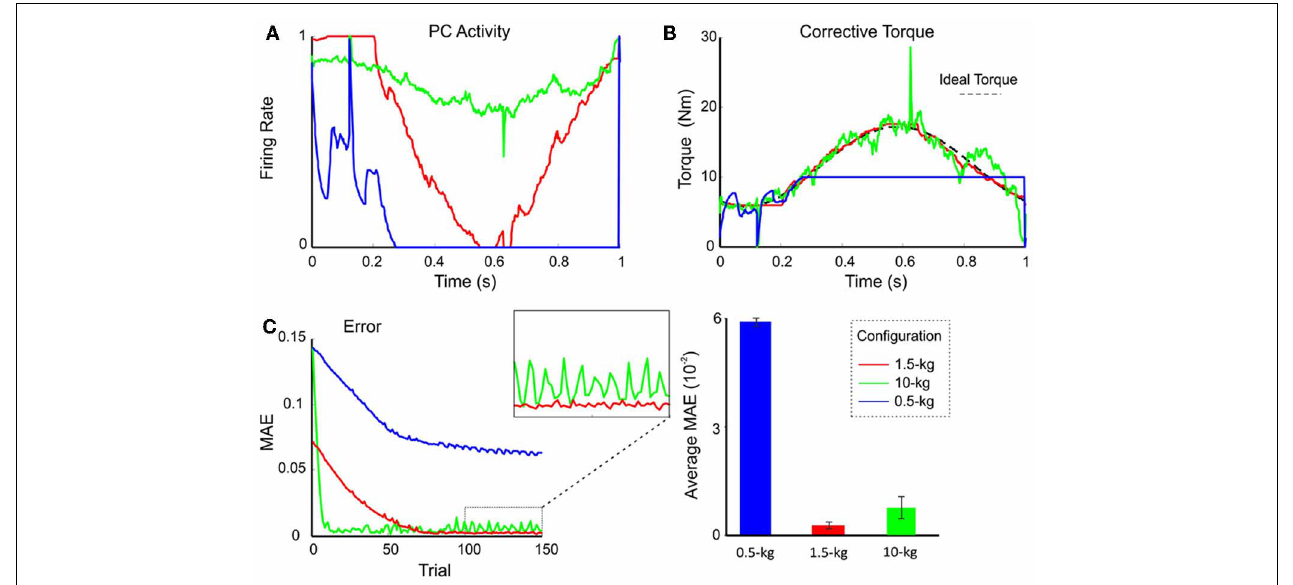
FIGURE 6 | Performance and learning with different weight configurations. Plasticity occurred only at PF-PC synapses, and was disabled at the MF-DCN and PC-DCN synapses. The synaptic weights were set at values appropriate for the manipulation of 0.5-kg ( blue lines ), 1.5-kg ( red lines ), and 10-kg ( green lines ) masses. In all three cases, 1.5-kg masses were actually manipulated. (A) Normalized activity of the PCs associated with the 2nd joint after 149 learning trials. For clarity, only the behavior of the second joint is shown, but similar results were found along the learning process also in joints 1 and 3. Note that by using the proper weight configuration (red line) ,